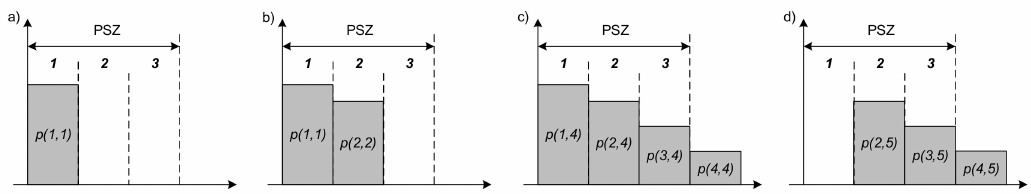
Figure 9. Graphic representation of the RFID system state: ( a ) first round; ( b ) second round; ( c ) fourth round; ( d ) fifth